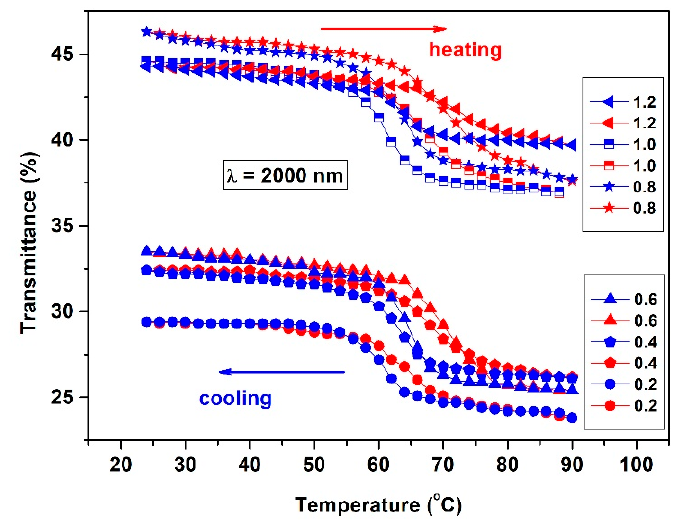
Figure 6. Transmittance hysteresis loop of VO 2 /PVP nanocomposite films prepared with different amounts of PVP, recorded at λ = 2000 nm. Heating (red line), cooling (blue line). Table 2. Critical transition temperature T C and width of transmittance hysteresis loop ( Δ T C ) of VO 2 /PVP nanocomposite films for different amounts of PVP.